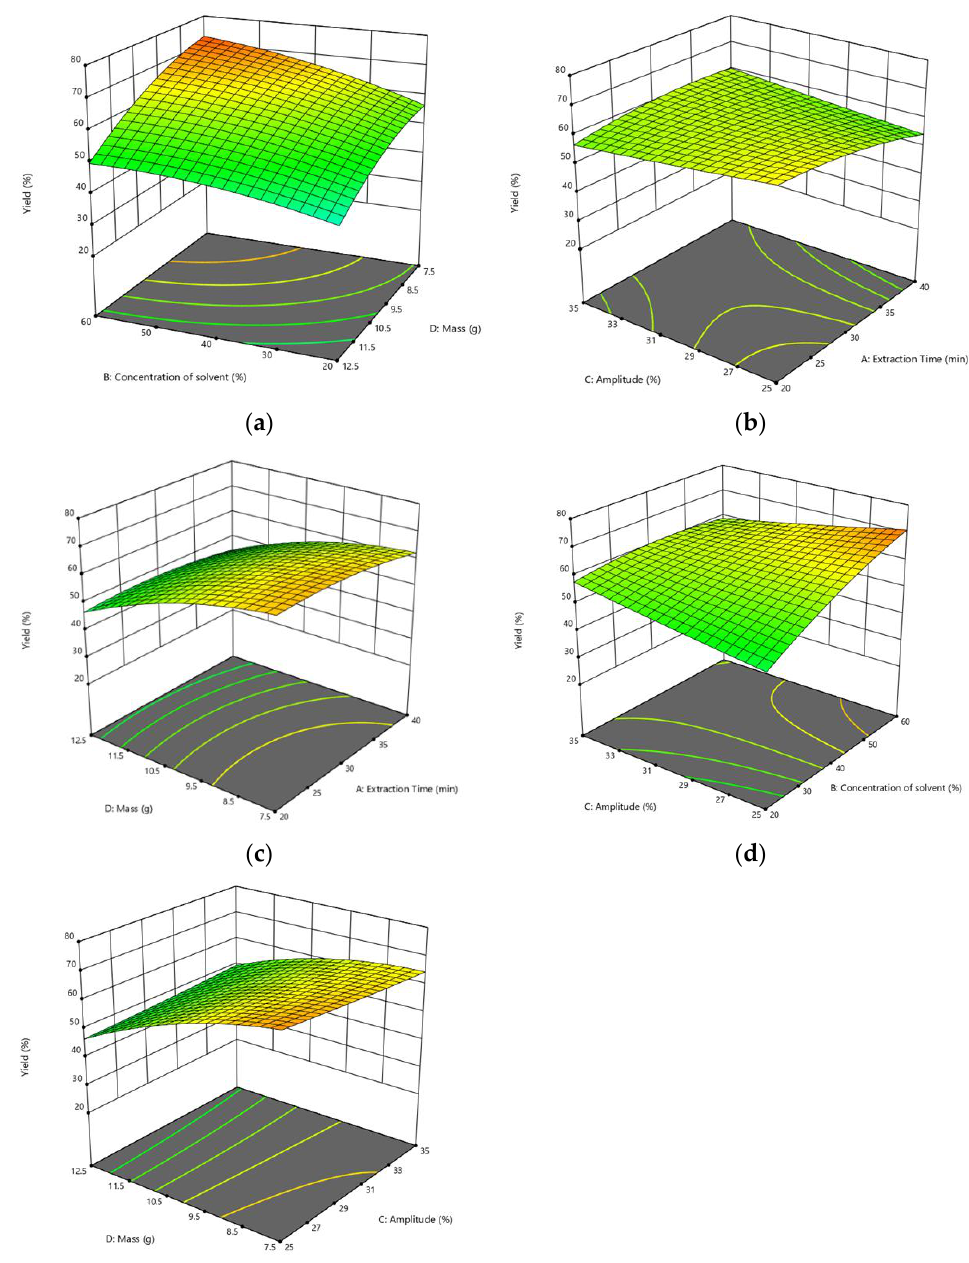
Figure 2. 3D response surface plots representing the effect of response variables towards the yield of pandan extract; ( a ) Effect of concentration of solvent and mass of leaves towards yield of extract; ( b ) Effect of sonication amplitude and extraction time towards yield of extract; ( c ) Effect of mass of leaves and extraction time towards yield of extract; ( d ) Effect of sonication amplitude and concentraction of solvent towards yield of extract; ( e ) Effect of mass of leaves and sonication amplitude towards yield of extract.